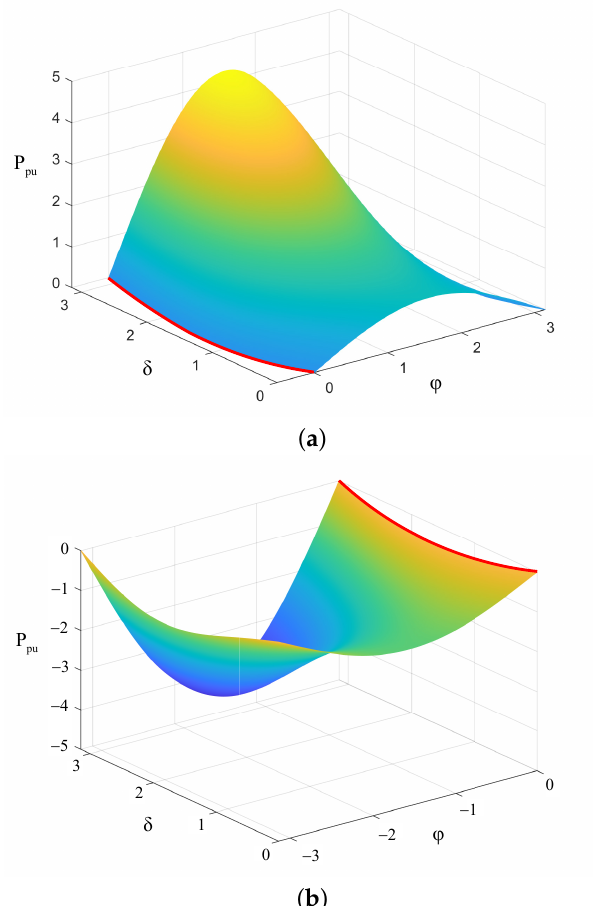
Figure 7. 3-dimensional plots of normalized power: ( a ) Fordward mode, ( b ) Backward